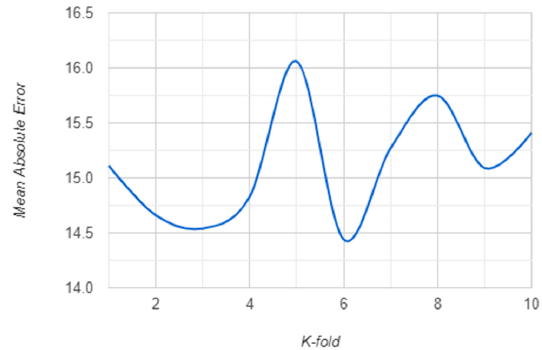
Figure 10. MAE for 10-fold cross-validation of the XGBoost model.